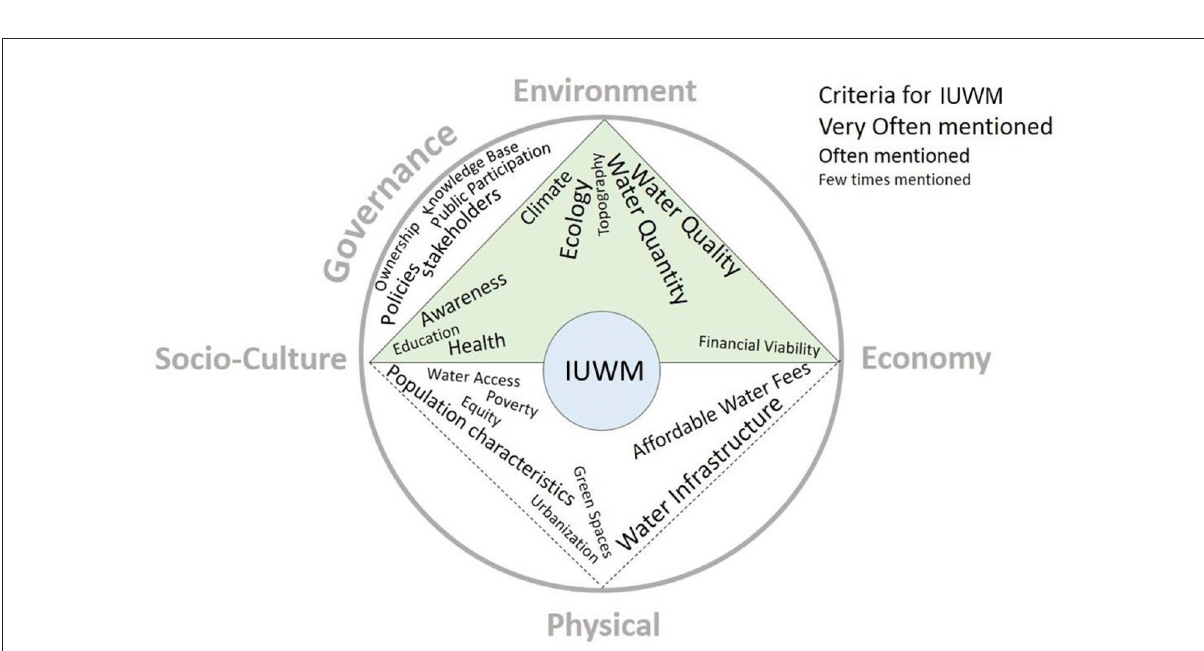
FIGURE2 The selected set of criteria classified into five dimensions (Environmental, Social, Physical, Economy, and Governance). The figure shows their relation to integrated urban water management. The governance dimension acts as the integrative actor between the other dimensions. A set of criteria is selected for each dimension (see details in Supplementary Appendix I). The importance of each is shown by its font size. Further analysis of the case studies based on the detailed criteria is presented in Supplementary Appendix II.